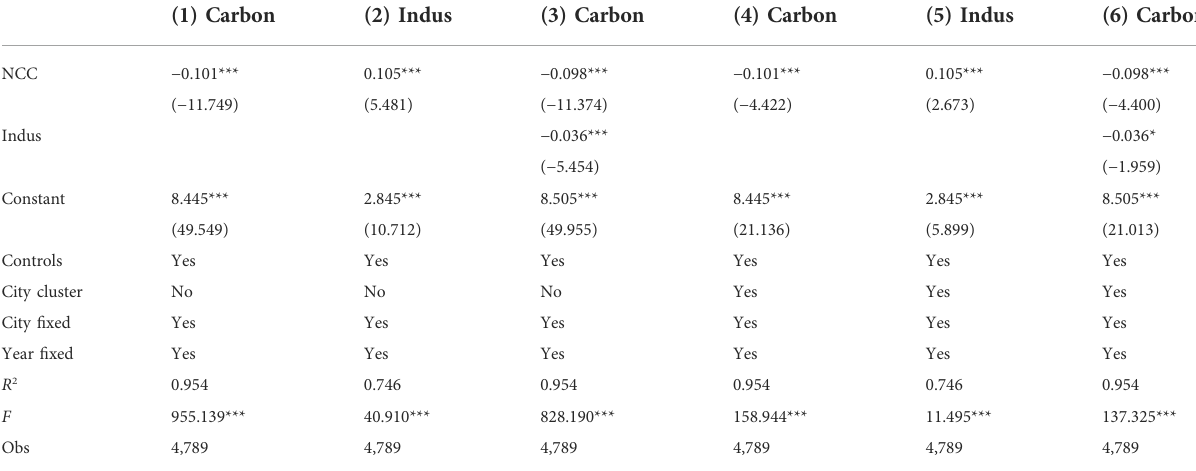
TABLE 6 Mechanism analysis based on industrial